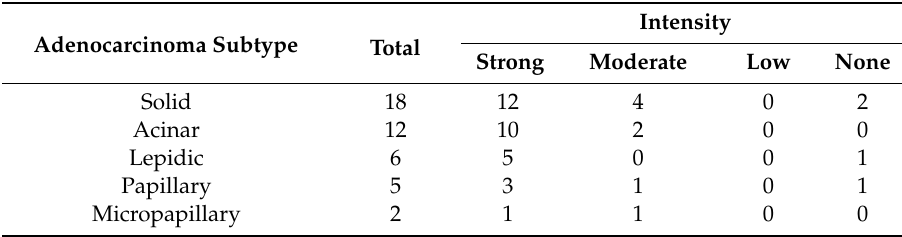
Table 2. Intensity of IL-6 staining in lung adenocarcinoma